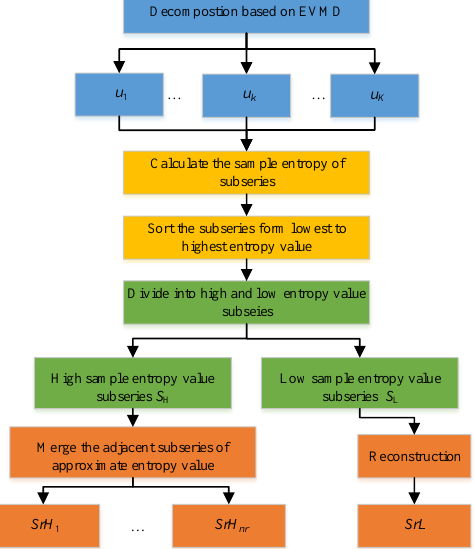
Figure 4. Framework of subseries reconstruction method.